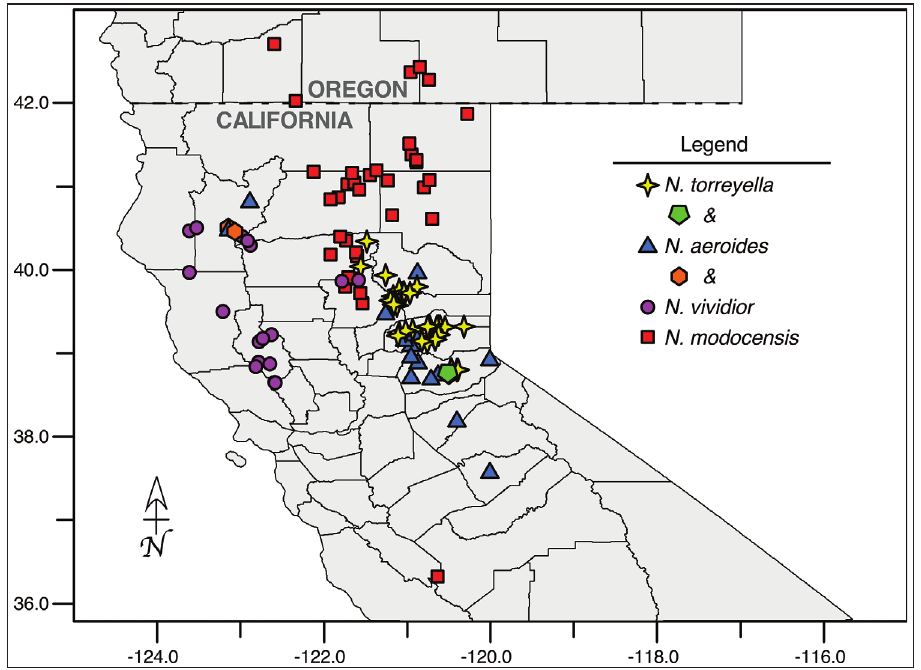
Figure 4. Distribution of Navarretia vividior (circles), N. modocensis (squares), N. aeroides (triangles), and N. torreyella (4-pointed stars) occurrences across their native range in California and southern Oregon, United States. Instances of observed syntopy are indicated with the hexagon and pentagon, as defined in the